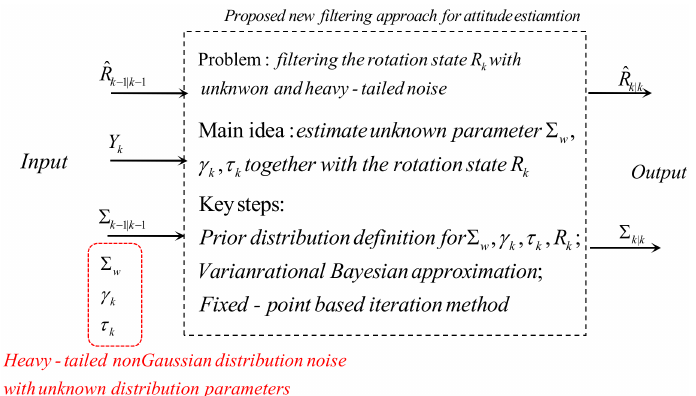
Figure 5. The main idea and key innovation of this work to deal with the heavy-tailed attitude estimation problem on matrix Lie group SO(3)